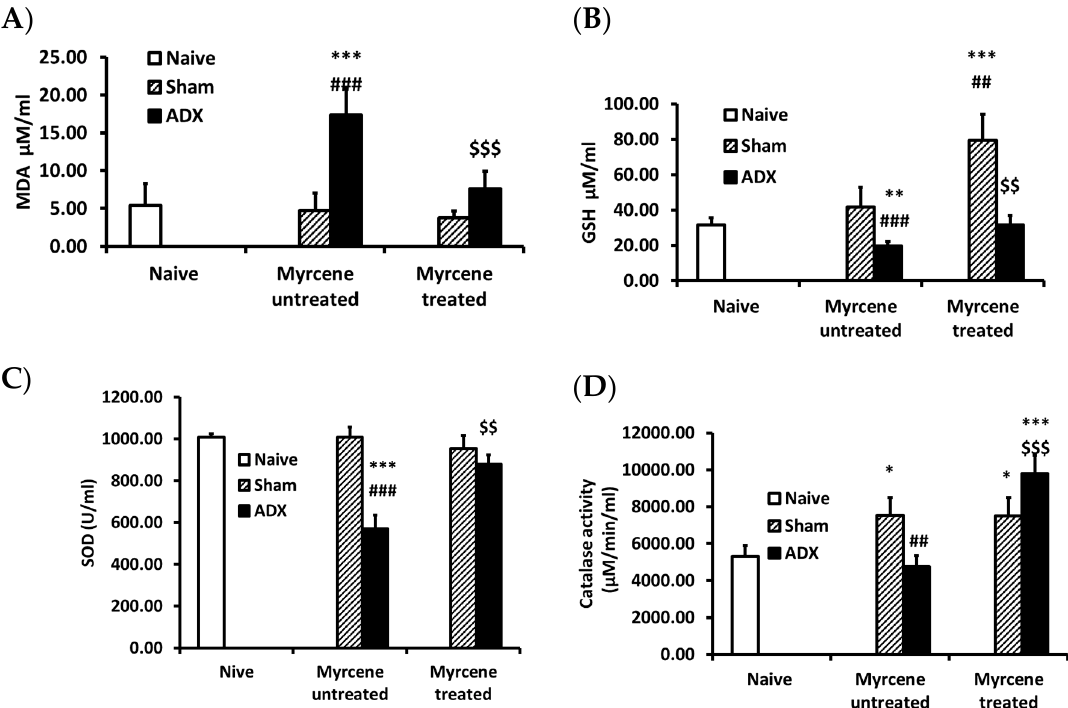
Figure 3. Quantification in kidney tissue after adrenalectomy of: ( A ) malondialdehyde (MDA); ( B ) glutathione (GSH); ( C ) superoxide dismutase (SOD); and ( D ) catalase (CAT). ADX induced a significant increase in MDA level and decreased GSH level in the untreated ADX group compared to the naïve and sham operated control rats. Myrcene treatment in ADX group rats significantly decreased the concentration of MDA, and increased the level of GSH. ADX significantly decreased the activity of SOD and CAT compared to the naïve and sham control rats. Myrcene treatment significantly up regulated SOD and CAT activity compared to the untreated ADX rats. Each data-point represents the mean ± STD of six to nine rats. * p < 0, ** p < 0.01, *** p < 0.001 compared to naïve; ## p < 0.01, ### p < 0.001 compared to untreated sham; $$ p < 0.01, $$$ p < 0.001 compared to untreated ADX.